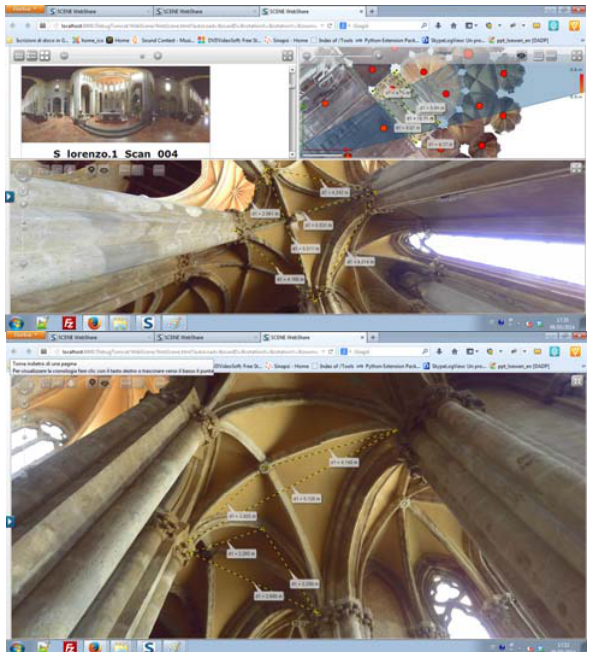
Figure 5 . Naples S. Lorenzo Maggiore. SCENE WebShare: using this system 360° immersive images could be considered a user interface to access 3D data.